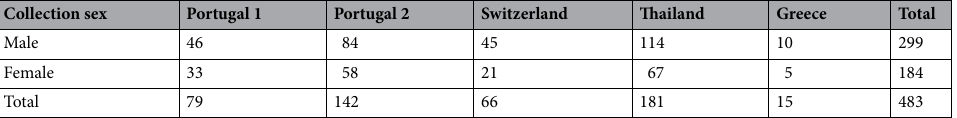
Table 1. Summary table of osteological collections and numbers of ossa coxae used in the present study for each sex separately. Portugal 1 = The 21st Century Identified Skeletal Collection (CEI/XXI); Portugal 2 = The Coimbra Identified Skeletal Collection